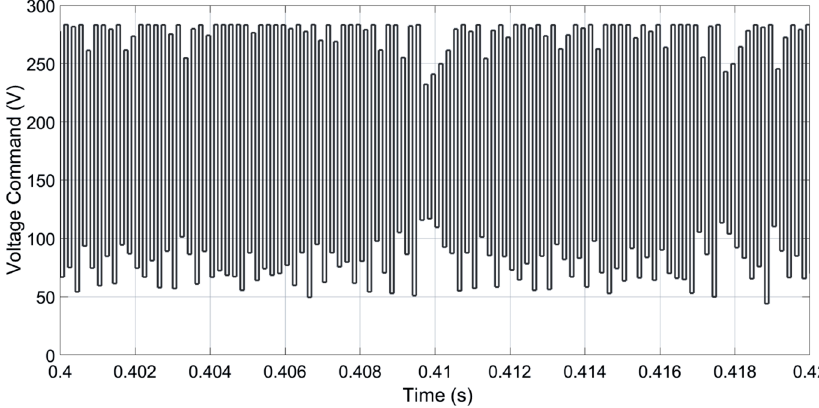
Figure 9. Voltage command for cSVM-DTC1 (10 kHz).